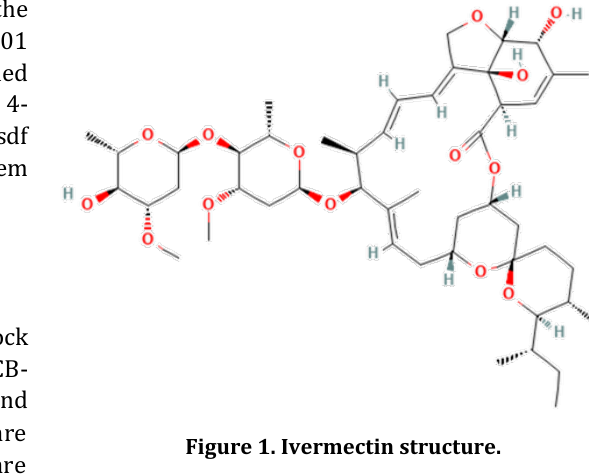
Figure 1. Ivermectin structure.